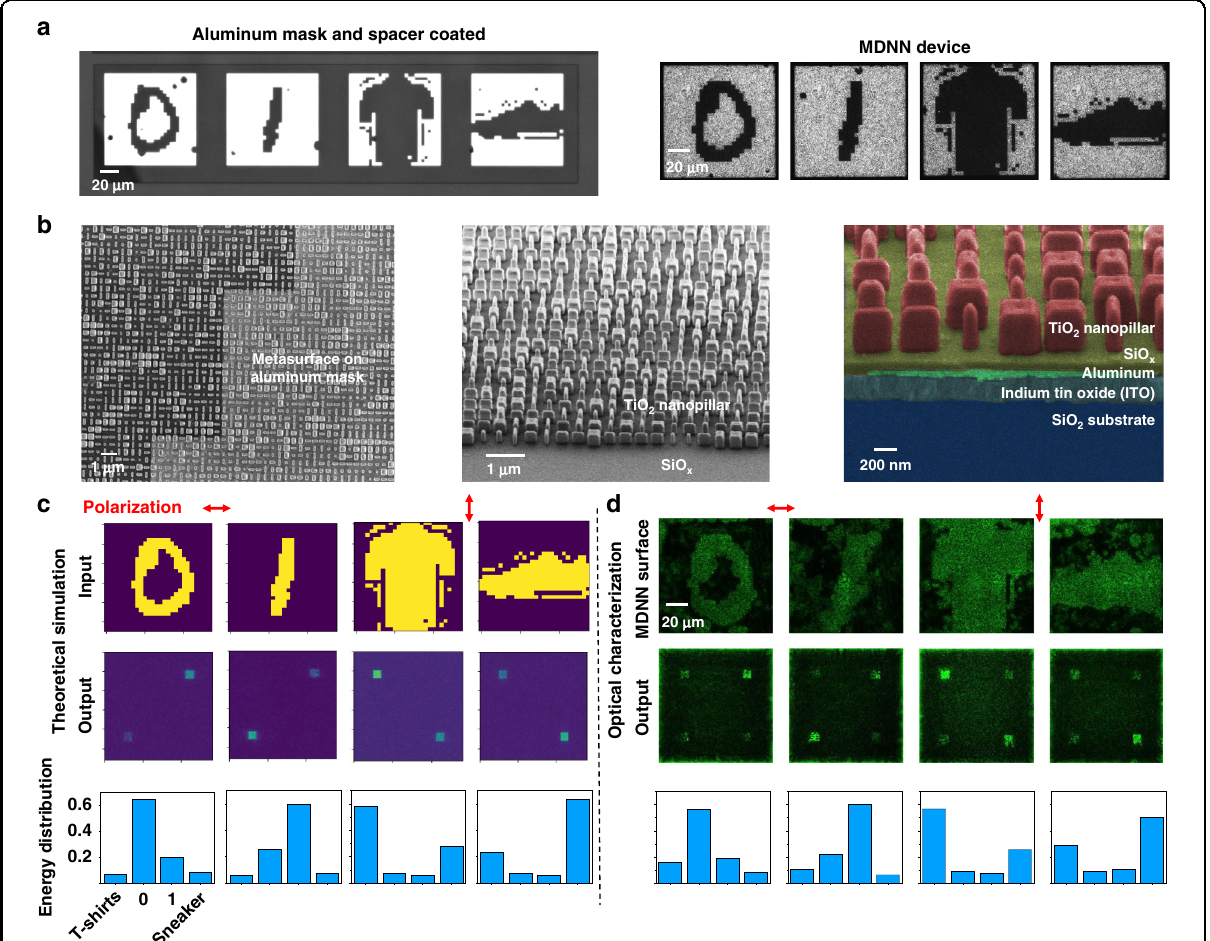
Fig. 4 Fabrication and optical veri fi cation of the dual-channel classi fi er MDNN. a Optical micrographs of masks formed after Al deposition and coated with a spacer layer (left), and the fi nally fabricated MDNN devices (right). b Top-view (left), oblique-view (middle), and false-color cross- sectional view (right) of the scanning electron microscope (SEM) images, respectively, of the MDNN. c Simulation inputs and outputs of the dual-class classi fi cation MDNN under orthogonal polarization, and their energy distribution. d The optical demonstration of the MDNN surface (top), the output fi eld intensity detected by a camera for these cases (middle), and energy distribution of the experiment results